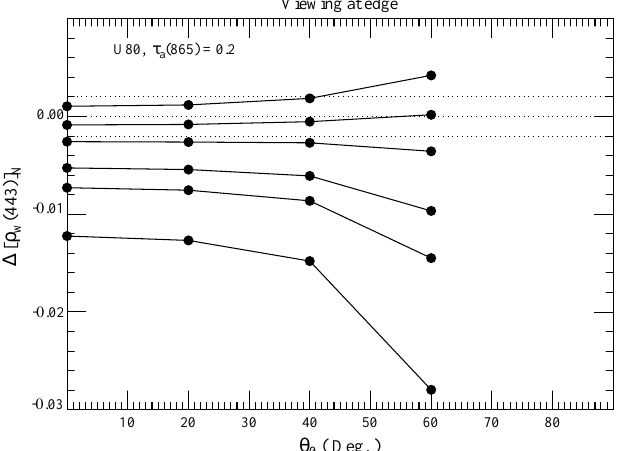
Figure 8. Effect of the vertical distribution of aerosol on the error ∆ [ ρ w ( 443 )] N as a function of θ 0 at the edge of the scan for the U80 aerosol model with τ a ( 865 ) = 0.2. Curves from top to bottom refer to situations in which U80 is confined to a layer just above the surface, between the surface and 1, 2, 4, and 6 km, and uniformly mixed throughout the atmosphere. From Gordon